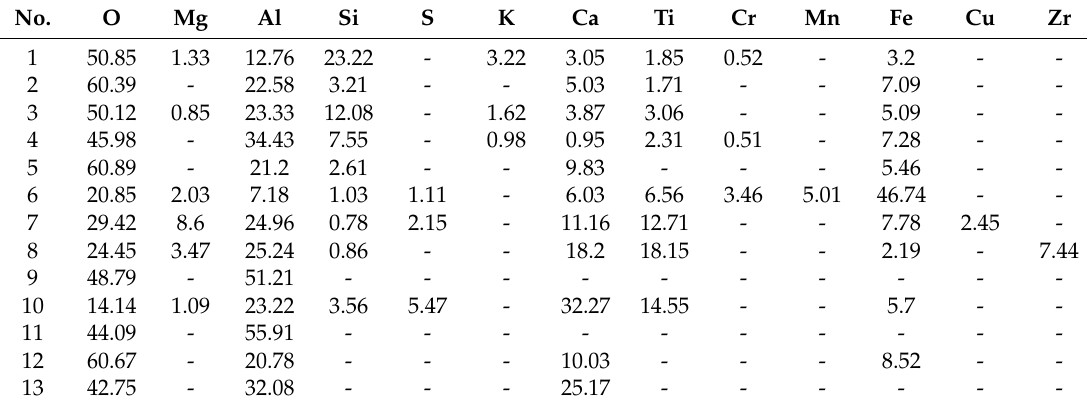
Table 2. Analysis results of inclusions compositions in Figure 2, wt %.